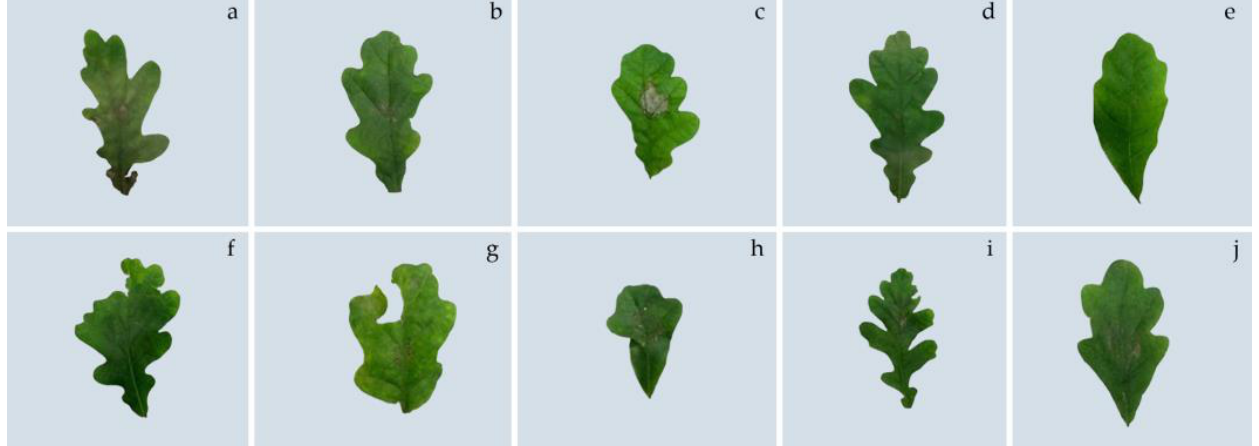
Figure 4. Inoculated leaves of annual oak plants by endophytes, epiphytic and pathogenic: ( a ) — control, ( b ) — Pectobacterium spp., ( c ) — Pseudomonas spp., ( d ) — Bacillus subtilis (Q2), ( e ) — Bacillus amyloliquefaciens (Q7), ( f ) — Q2/Q7 (mix 1:1), ( g ) — Lelliottia amnigena (Q5), ( h ) — Delftia acidovorans (Q6), ( i ) — EpQ1, ( j ) — EpQ2 .